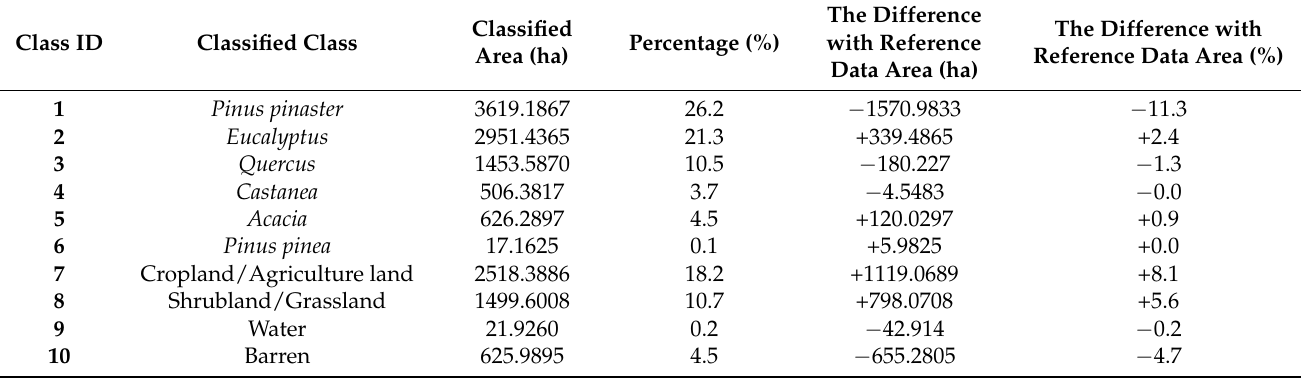
Table A2. Classification result represented in the area (ha) and percentage.